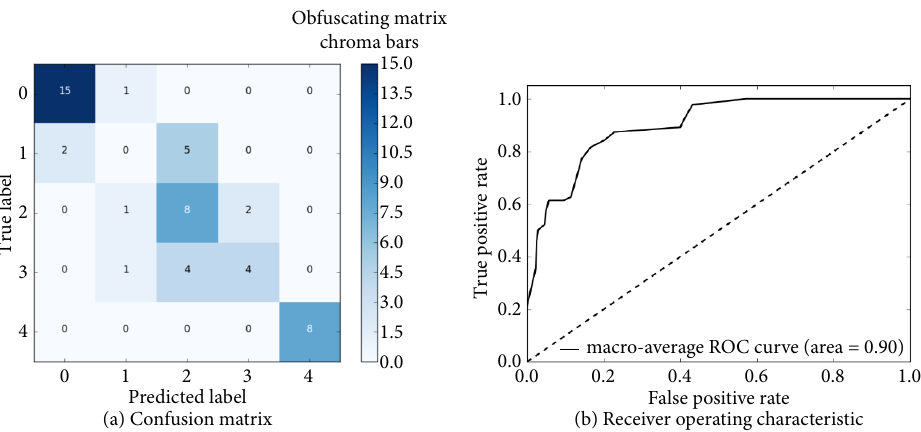
Fig. 7 Confusion matrix and ROC curve of the neural network classification.